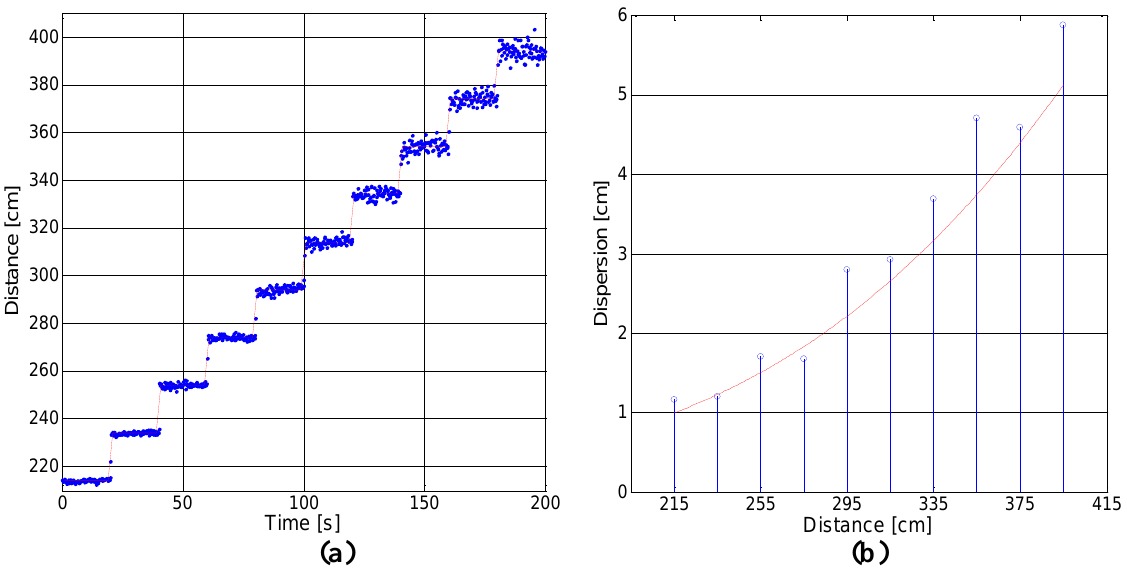
Figure 15. (a) Distance measurements using one receiver; (b) Dispersion for each distance